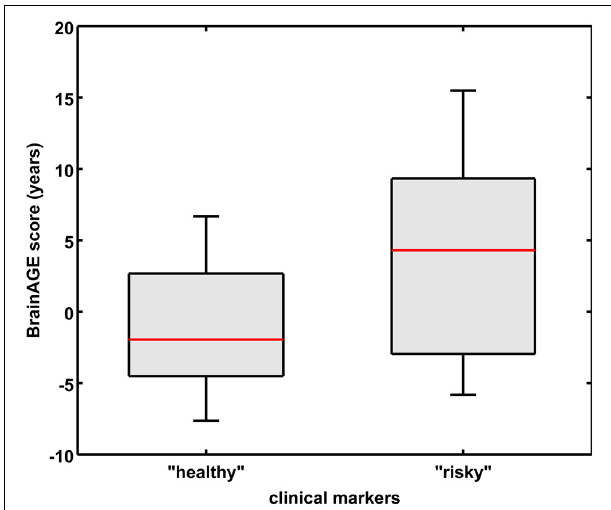
FIGURE 7 | Combined analysis of physiological and serum data parameters in the female sample. BrainAGE score distributions of female subjects with “healthy” clinical markers (i.e., values equal to or below the medians of GGT, ALT, AST, and values equal to or above the median of vitamin B 12 ; n = 14) vs. “risky” clinical markers (i.e., values equal to or above the medians of GGT, ALT, AST, and values equal to or below the median of vitamin B 12 ; n = 13; p < 0 . 05). Gray boxes contain values between the 25th and 75th percentiles of the groups, including the median. Error bars indicate data within 1.5 times the interquartile range. The width of the boxes is proportional to group size.